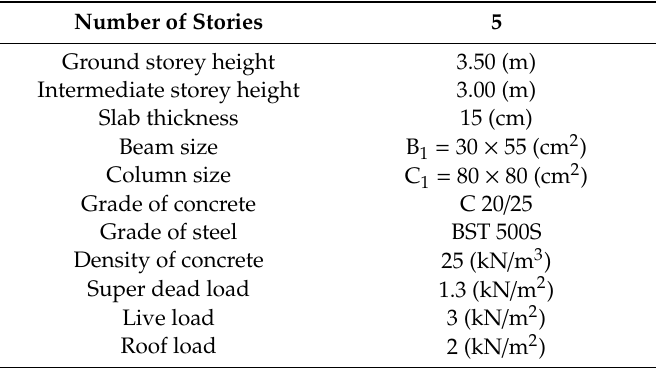
Table 1. Input data corresponding to the structure.